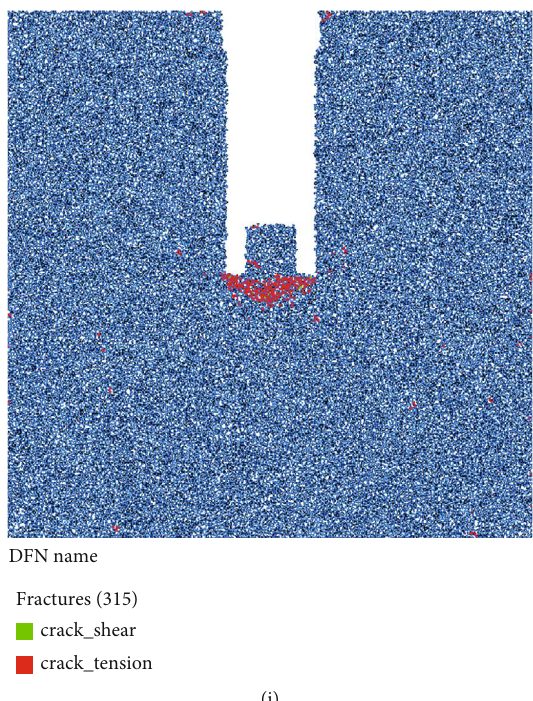
σ σ σ V = H = 50MPa . (b) V = H = 70